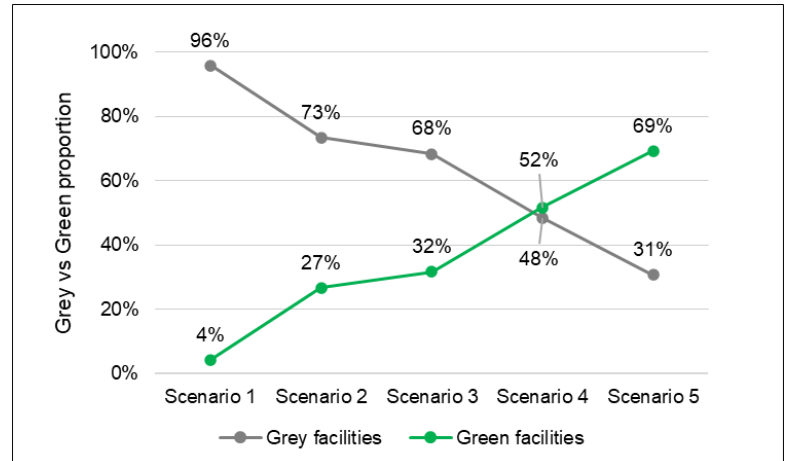
Figure 4. Di ff erent proportion of grey and green WSUD facilities in di ff erent Figure 4. Different proportion of grey and green WSUD facilities in different scenarios.